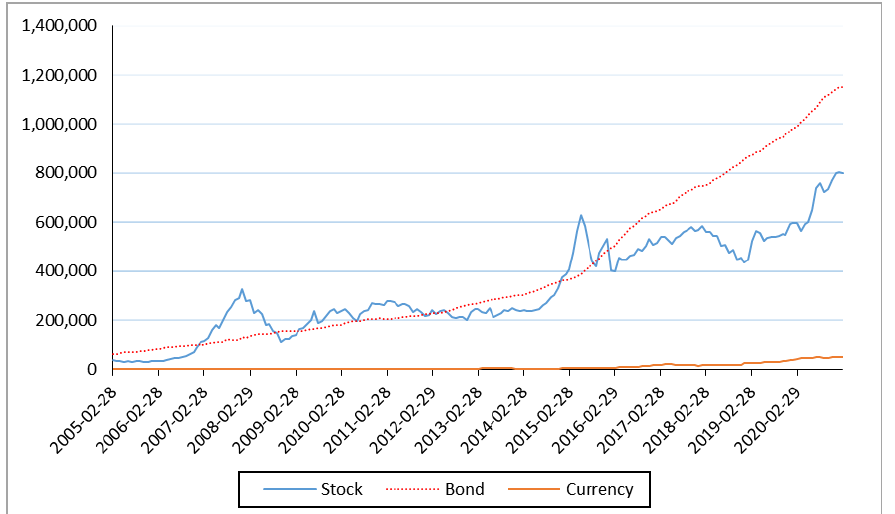
Figure 3. Market value changes of the three types of assets.